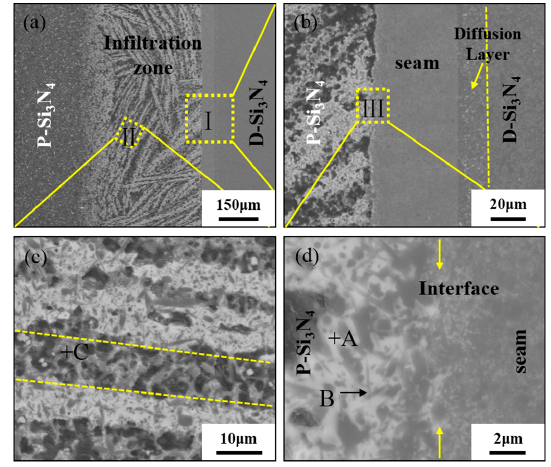
Figure 2. Backscattered SEM images of ( a ) the joint between P-Si 3 N 4 and D-Si 3 N 4 using Y-SiAlON glass solder at 1650 °C for 30 min. ( b ) The magnified morphology of Zone I, ( c ) the magnified morphology of Zone II, and ( d ) the magnified morphology of Zone III, respectively.